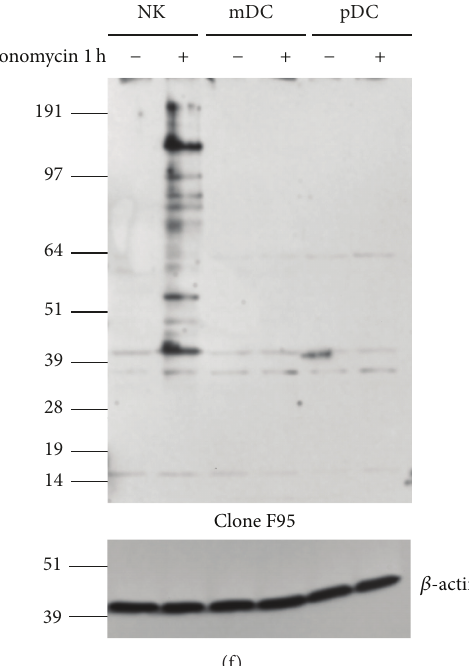
Figure 4: Hypercitrullination in other leukocytes. (a) Neutrophils, (b) PBMC, (c) monocytes, and (d) T cells were isolated from the same donor and cultured with or without 1 𝜇 M ionomycin, 100 nM PMA, and 0.005% Triton-X for one hour in medium with 2 mM CaCl 2 . Citrullination was detected with the F95 antibody (upper panel) and equal loading verified with anti- 𝛽 -actin (lower panel). The shown blots are representative of four different donors. (e) B cells were isolated and cultured with or without 1 𝜇 M ionomycin in 2mM CaCl 2 medium. The indicated number of cell equivalents was loaded and citrullinated proteins were detected by F95 antibody (left panel) or anti-modified citrulline clone antibody (AMC) (right panel). The shown blots are representative of five different donors. (f) NK cells, myeloid dendritic cells (mDC), and plasmacytoid dendritic cells (pDC) were incubated in medium with 2 mM CaCl 2 medium alone or with 1 𝜇 M ionomycin for 1h, as indicated. Citrullination was detected with the F95 antibody (upper panel) and equal loading verified with anti- 𝛽 -actin (lower panel). The blot is representative of three different